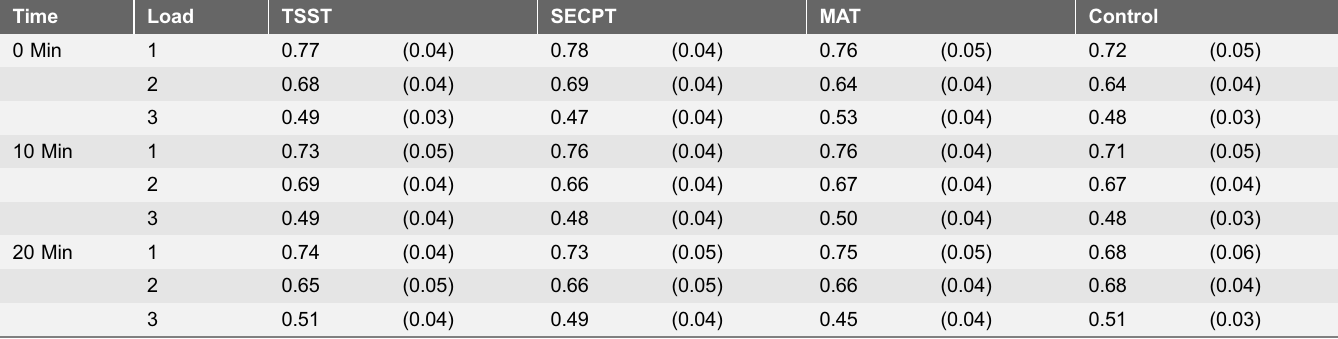
Table 3. N-Back Hit Rate as a function of Stress and Load (means and SE) at baseline and 0-, 10- and 20-minutes post-stress. Time Load